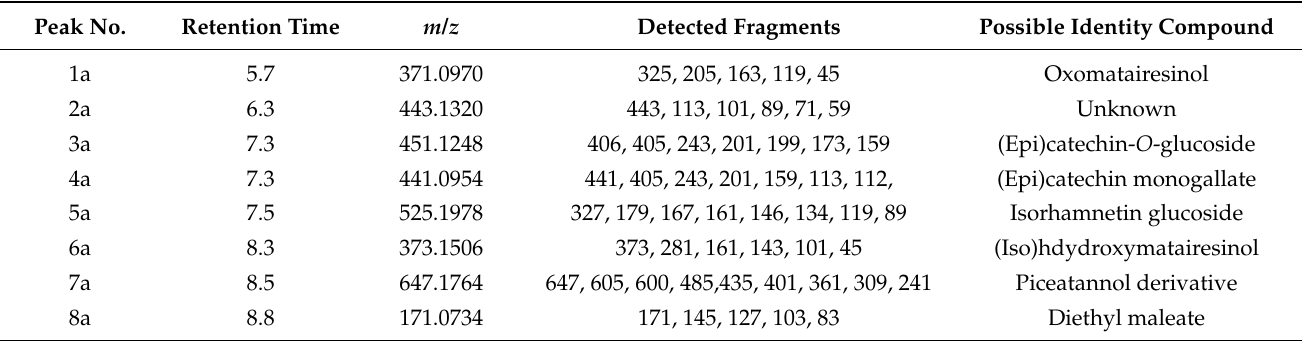
Table 2. Discernible peaks in DAD analysis that were not identified with targeted analysis. A possible identity was given with untargeted analysis.